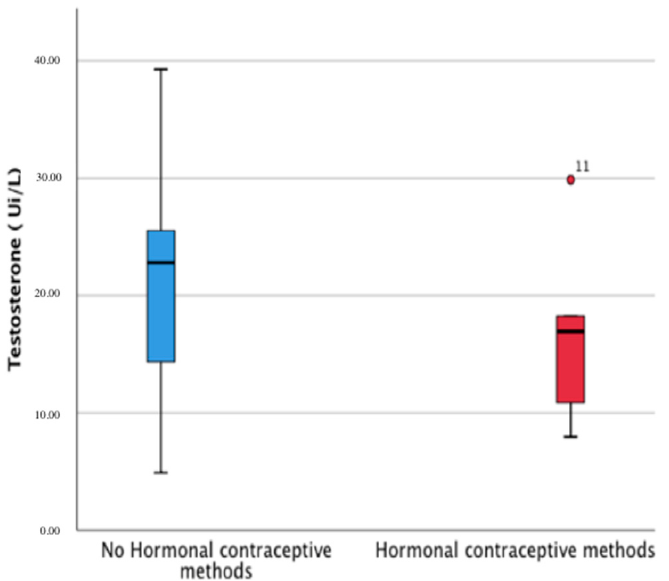
Figure 4. Testosterone levels (IU/L) in the non-HC and HC method groups.